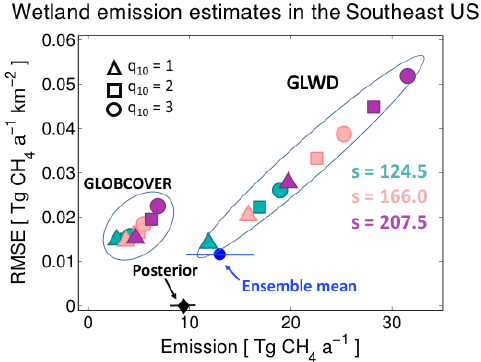
Figure 6. Range of wetland emission estimates in the Southeast US (domain of Fig. 1) for August–September 2013. The figure shows the spread of the WetCHARTs extended ensemble and com- pares with the posterior emission estimate from our inversion in terms of emission total and root-mean-square error (RMSE) on the 0 . 25 ◦ × 0 . 3125 ◦ spatial grid. The RMSE of the posterior emission estimate with itself is zero by definition. WetCHARTs ensemble members use wetland areal extent data from either the GLOB- COVER (Bontemps et al., 2011) or GLWD (Lehner and Dölla, 2004) databases, as well as different estimates of temperature sen- sitivity q 10 and global scaling factors s (see Eq. 5 and text). The posterior wetland emission estimate from our inversion is shown as black solid diamond with its associated error standard deviation. The mean of the WetCHARTs ensemble used as prior for our inver- sion is shown as blue solid circle with its associated error standard